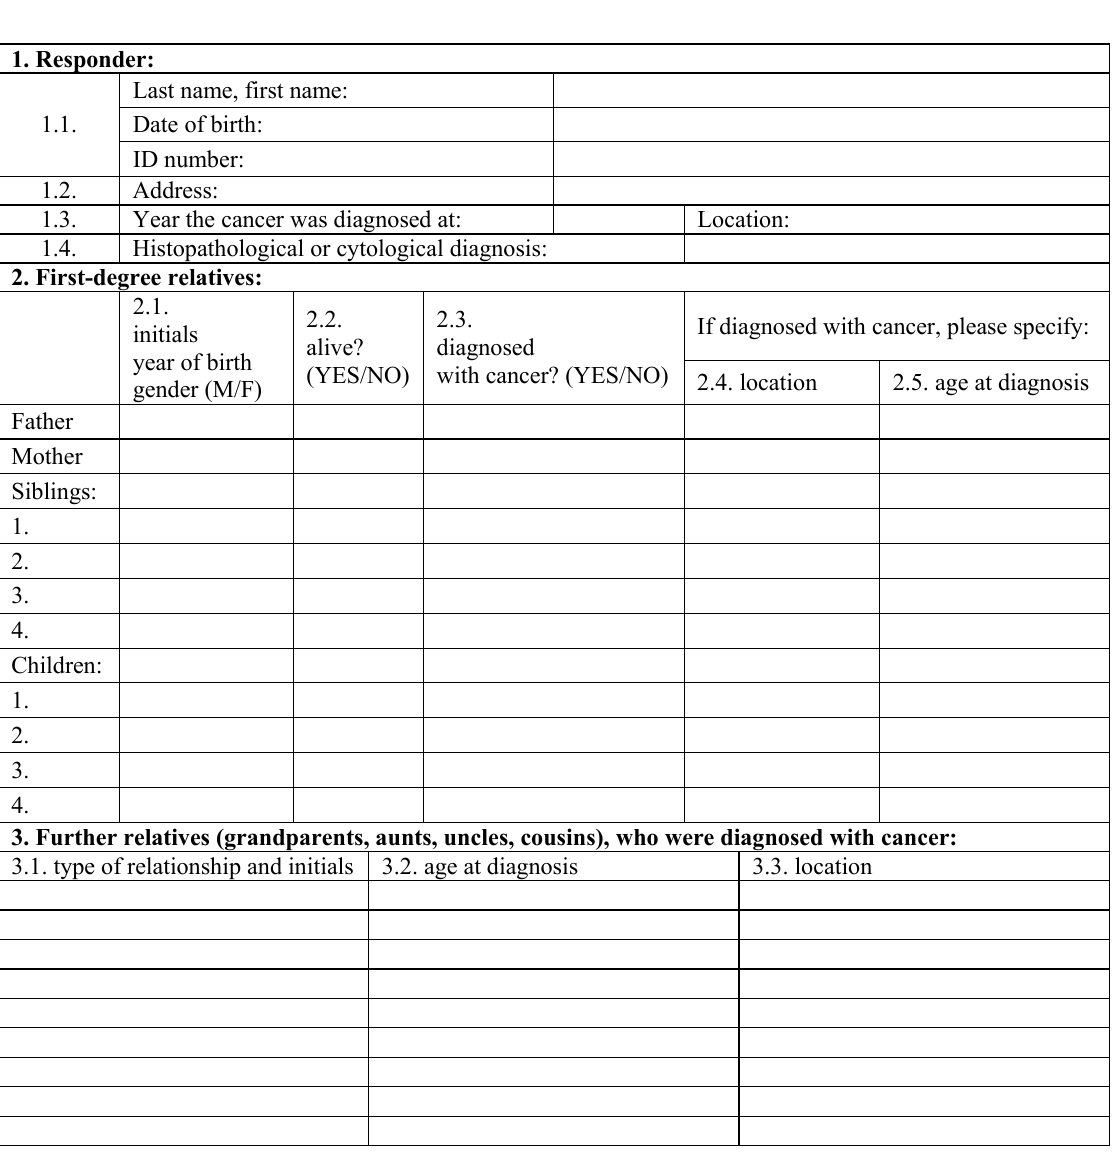
Fig. 2 Questionnaire on familial episodes of cancer used during the